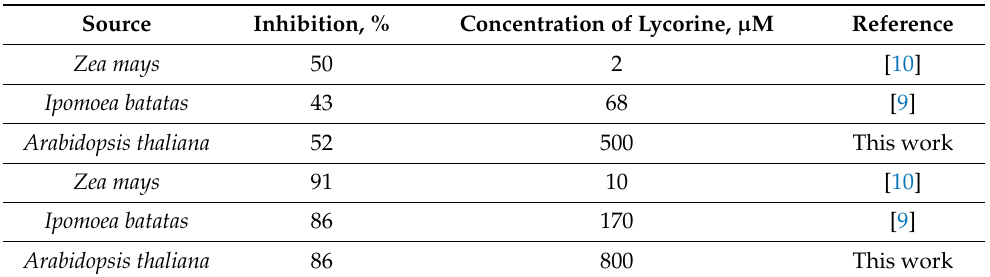
Table 3. Comparison of the inhibitory effect of lycorine on the activity of L -galactone-1,4-lactone dehydrogenases from various sources at approximately 50 and 90% inhibition.